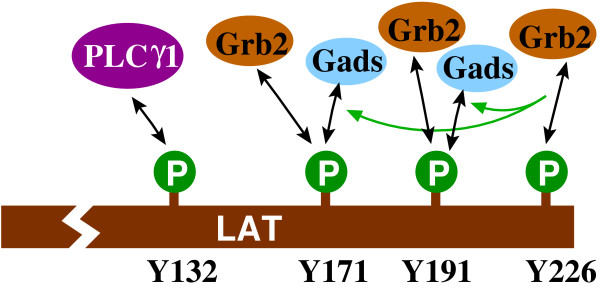
Linker for activation of T-cells. The four distal tyrosine rests on LAT and the binding possibilities, according to [26, 28].